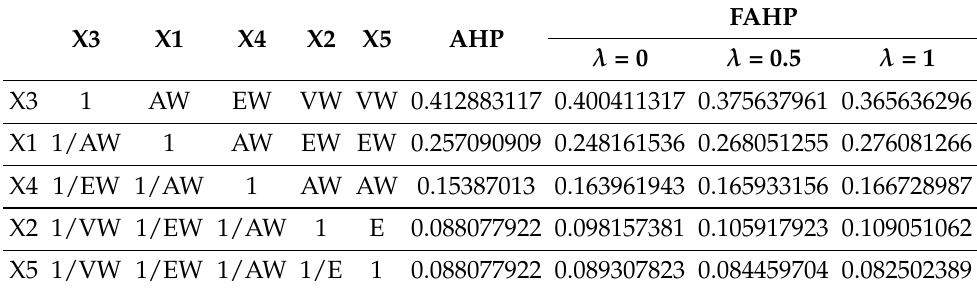
Table 3. Fuzzy comparison matrix and weights for the criteria. ( CI = 0.009091, CR = 0.008117).